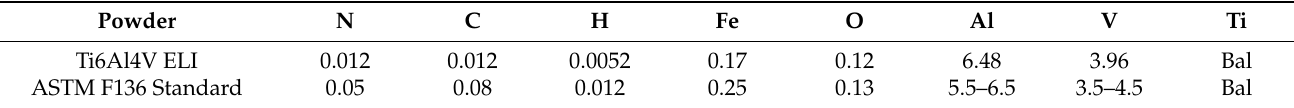
Table 1. Chemical composition of Ti6Al4V ELI